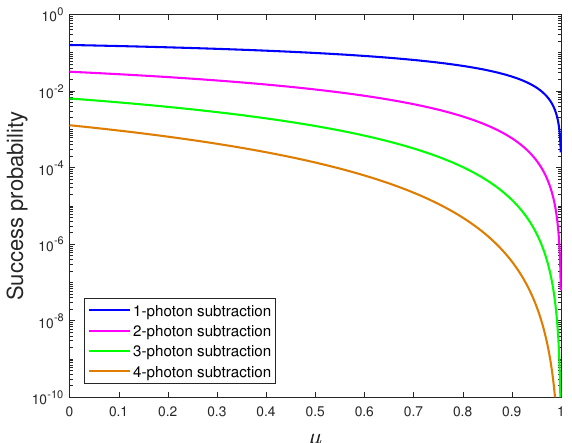
Figure 3. The success probability of photon subtraction as a function of transmittance µ for the modulation variance V M =